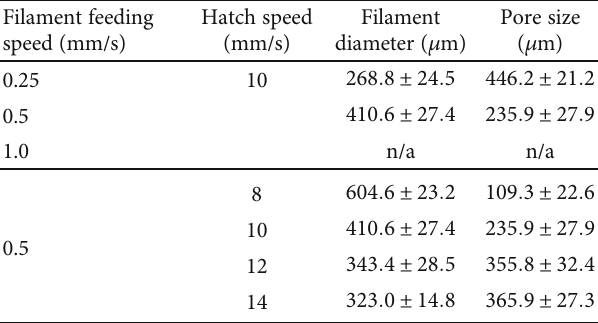
Figure 2: The 50/50 PCL/PHBV sca ff olds fabricated using the fi lament feeding speeds of (a) 0.25, (b) 0.5, and (c) 1.0mm/s under a constant hatch speed of 10 mm/s. Table 1: Filament diameters and pore sizes of 50/50 PCL/PHBV from FDM with di ff erent fi lament feeding speed and hatch